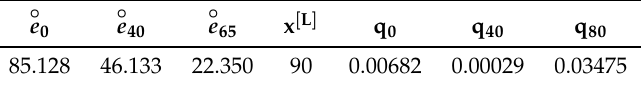
Table 2. The first Heligman–Pollard law: some markers.